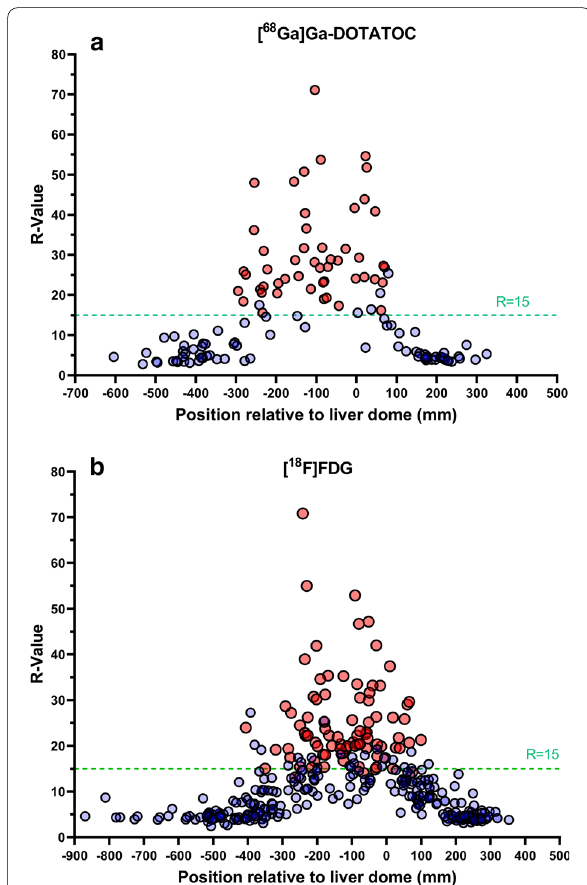
Fig. 1 Resulting R values for the assessed bed positions, [ 68 Ga] Ga-DOTATOC (n 128) ( a ) and [ 18 F]FDG (n 352) ( b ), as a function = = of the centre position of the bed position relative to the liver dome. Negative and positive values represent centre positions inferior and superior to the liver dome, respectively. The red dots represent all bed positions that were triggered for motion correction during prospective scanning and the blue dots represent those that were